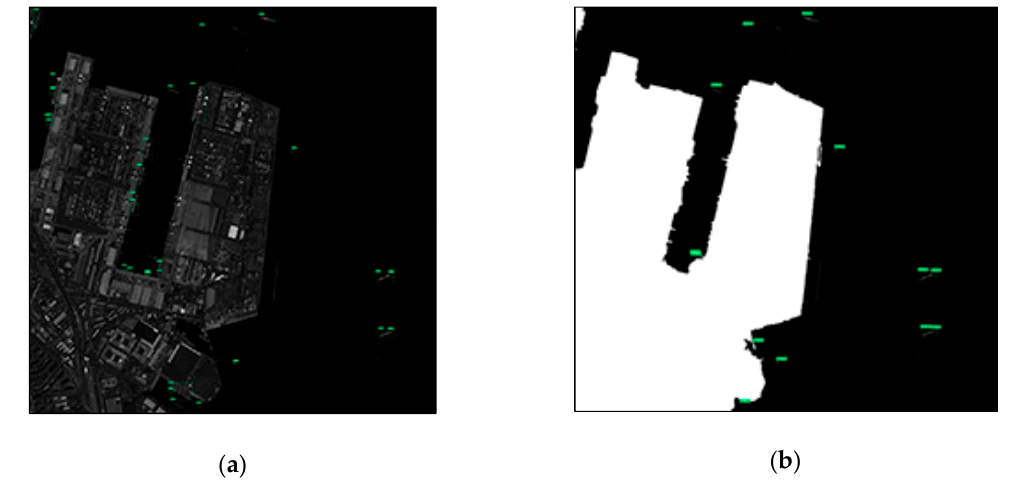
Figure 12. The detection results of the partial region of the JL-1(2) image. ( a ) Test results using network with a proportion of positive to negative samples of 1:1. ( b ) Test results using network with a proportion of positive to negative samples of 1:1 after FCN-based segmentation.